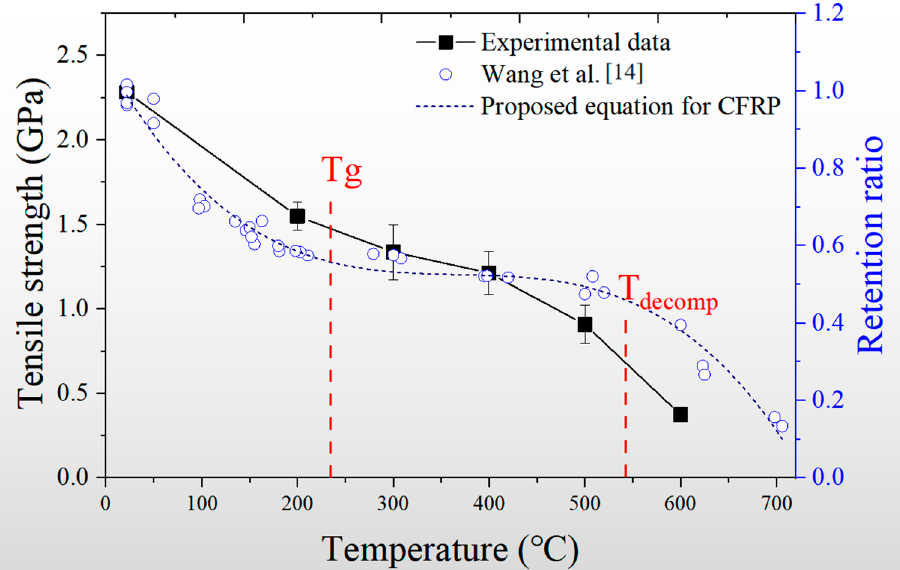
Figure 6. Variety curve of strength with temperature.